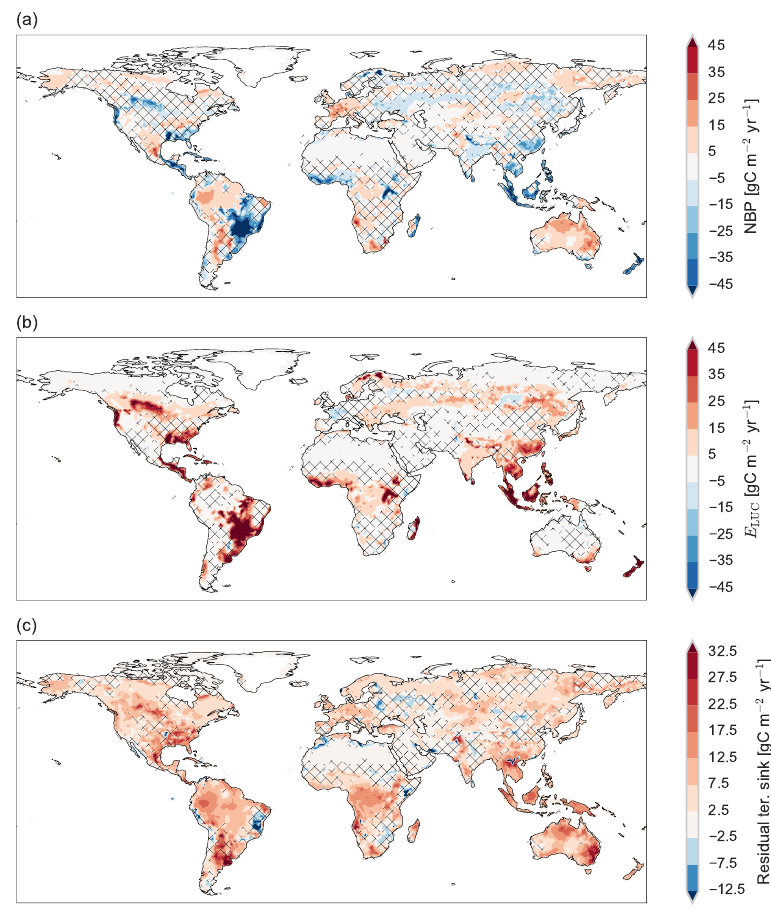
Figure 4. Skill weighted median annual net biome production (NBP) (a) , emissions due to land-use change E LUC (b) and the residual terrestrial sink flux (c) from 1901 to 2016 for the ensemble M gross , net . Areas where the lower and upper limit of the 90% confidence interval have different signs are